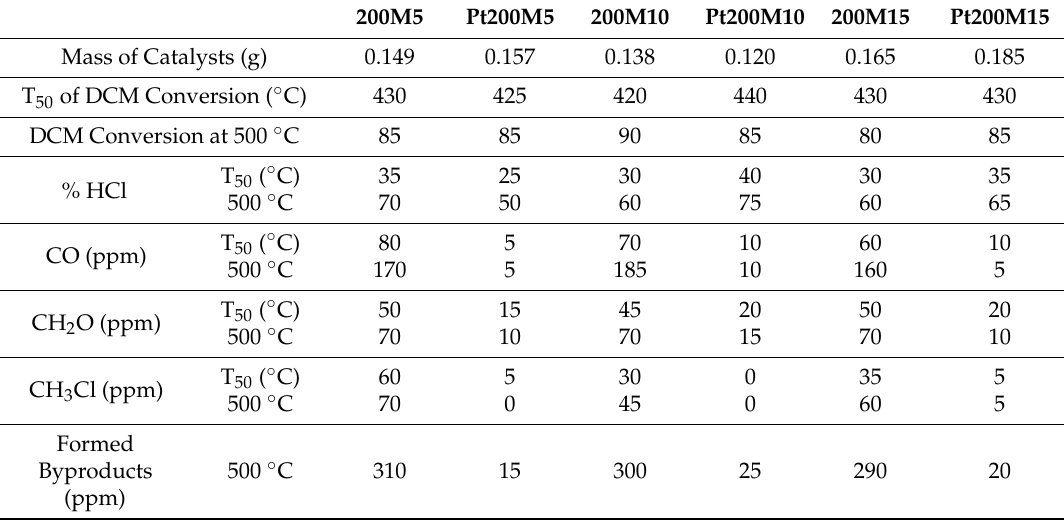
Table 6. DCM conversions, HCl yield and byproduct amount over different 200Mx based catalysts.